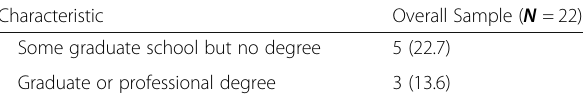
Table 1 Demographic and clinical characteristics collected at screening